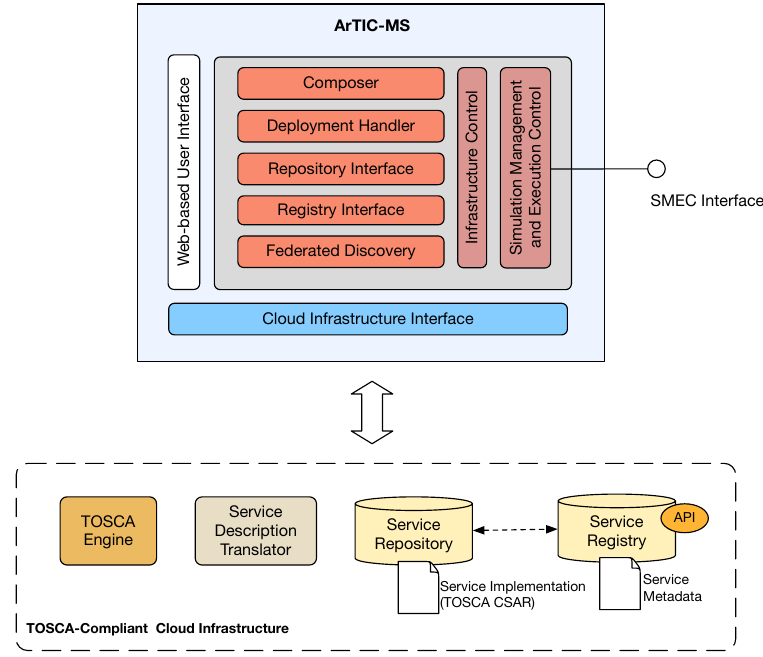
Figure 4. Conceptual architecture of